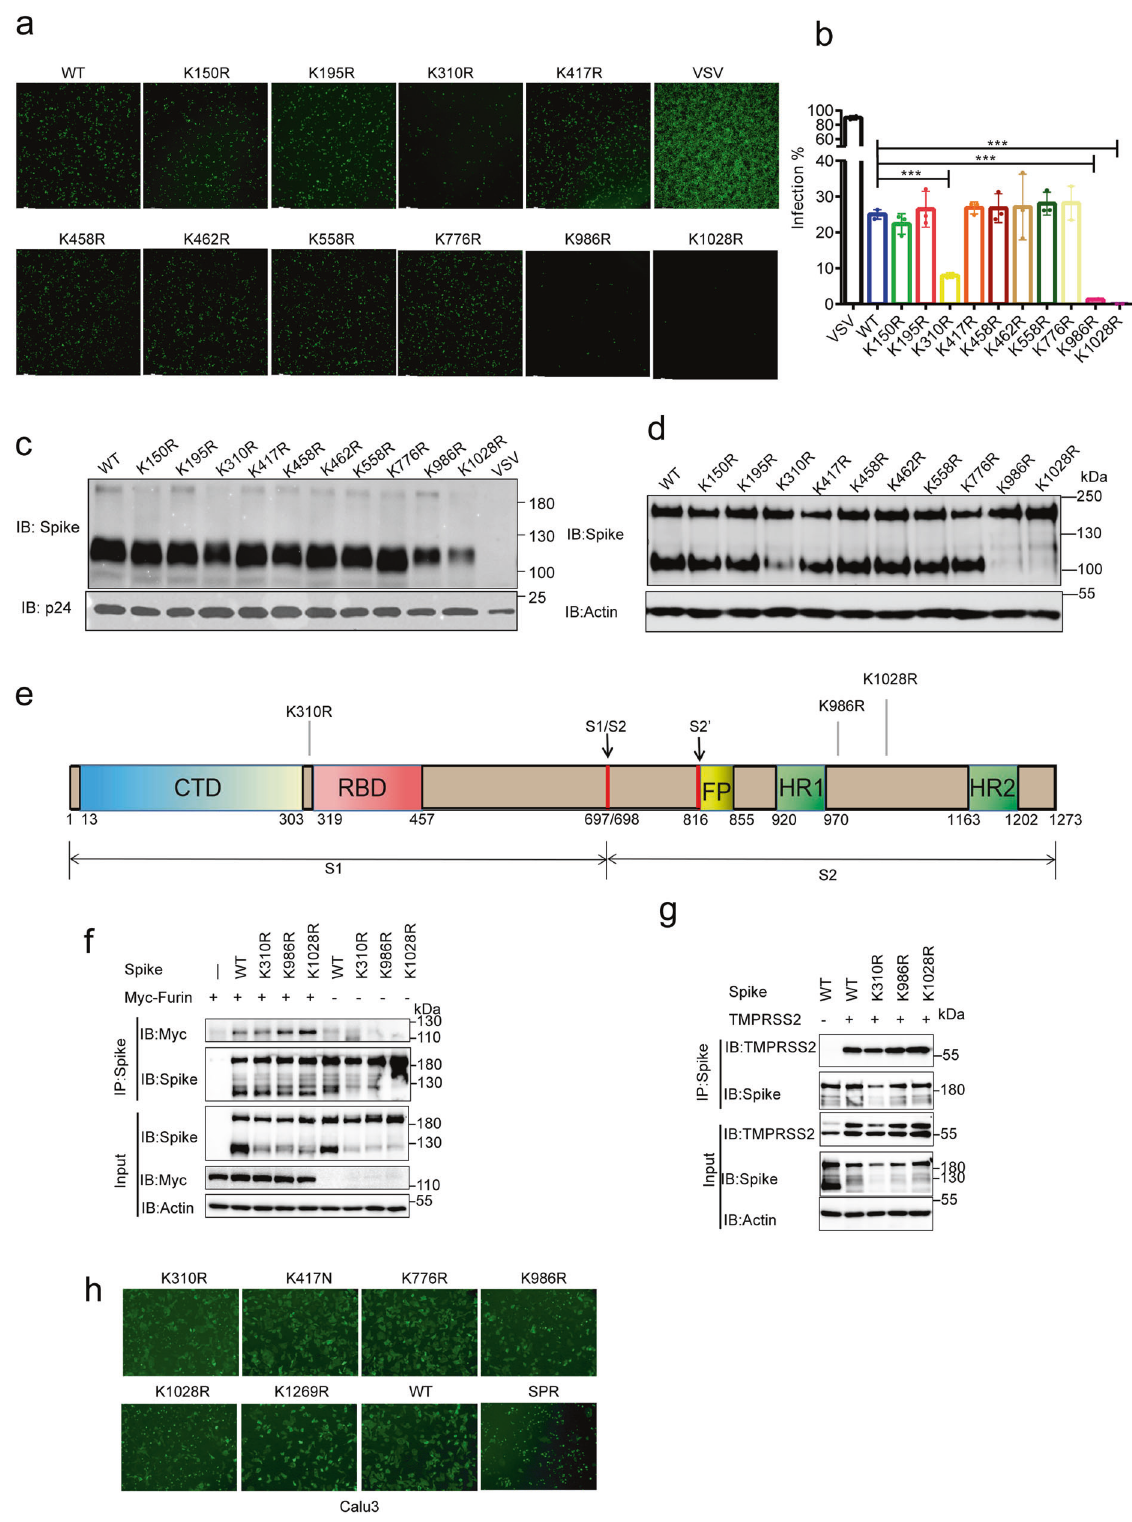
Boiled cell lysates were separated by SDS – PAGE gels. Then transferred it onto polyvinylidene di fl uoride (NC) membranes (Millipore, IPFL10100). Blocking with 5% BSA in TBST buffer, then the blot was orderly probed with primary antibodies and the horseradish peroxidase (HRP)-conjugated secondary antibody. Signal Transduction and Targeted Therapy (2022)